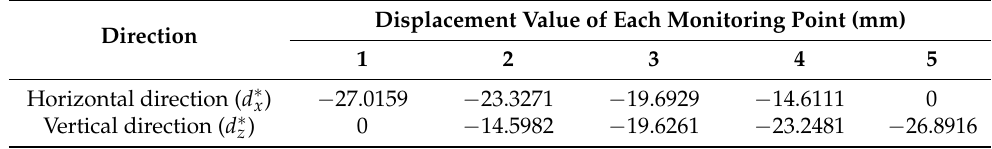
Table 3. The measured displacements of